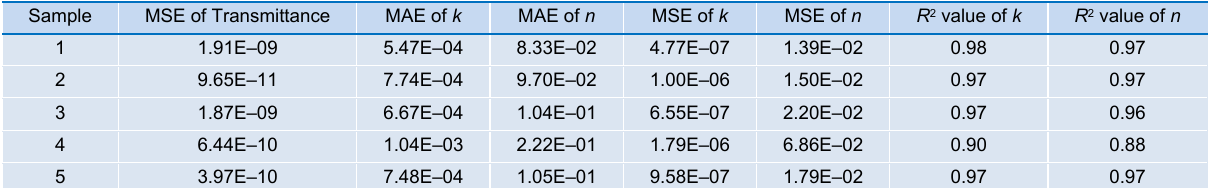
Table 4 | Validation of proposed methodology.